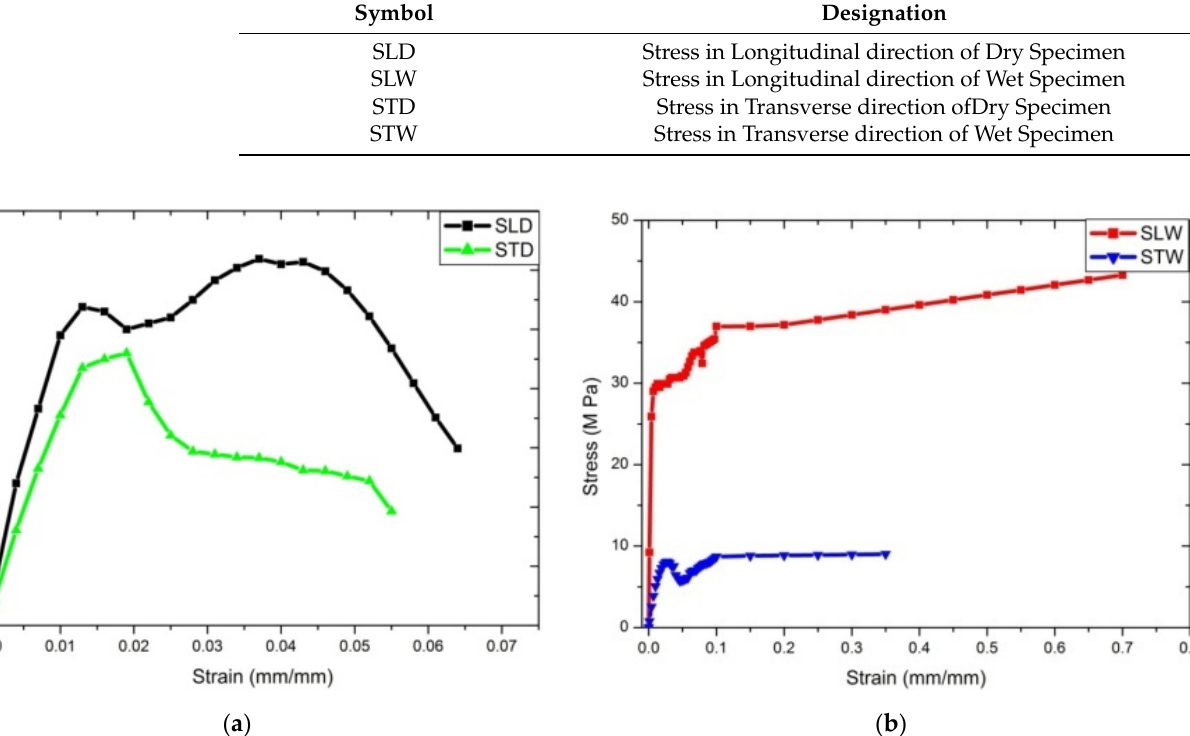
Figure 7. ( a ) Longitudinal and transverse stress–strain curve for dry conditions and ( b ) longitudinal and transverse stress–strain curve for wet conditions.